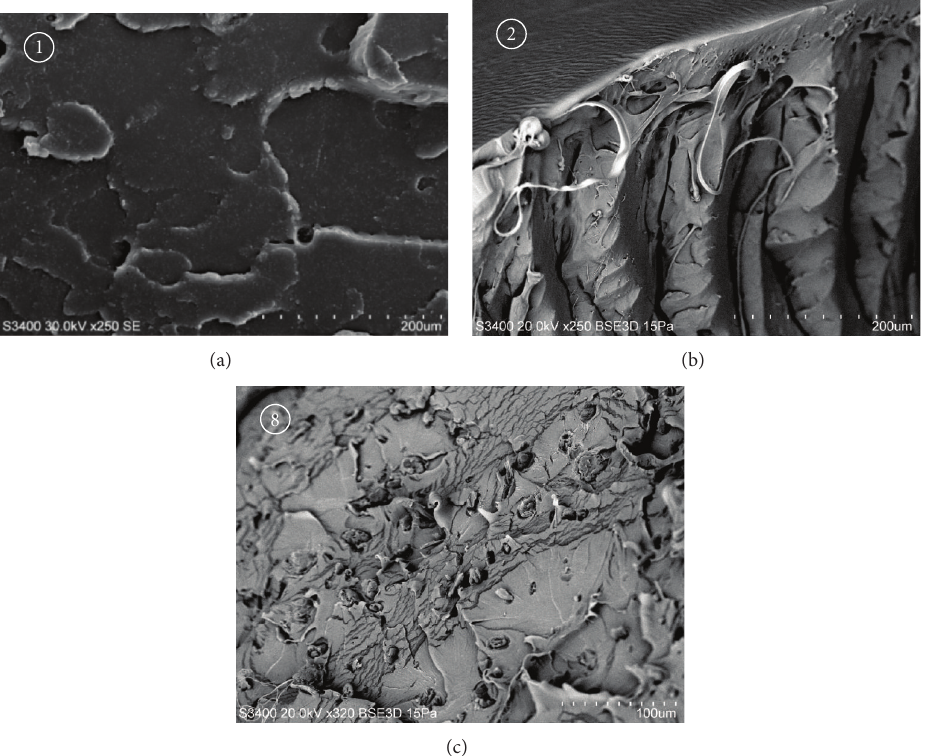
F 7: SEM micrographs of the tensile fractured surfaces.